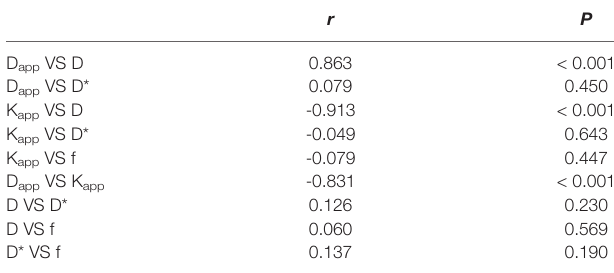
TABLE 3 | The correlation analysis of quanti fi cation parameters of IVIM and DKI. r P